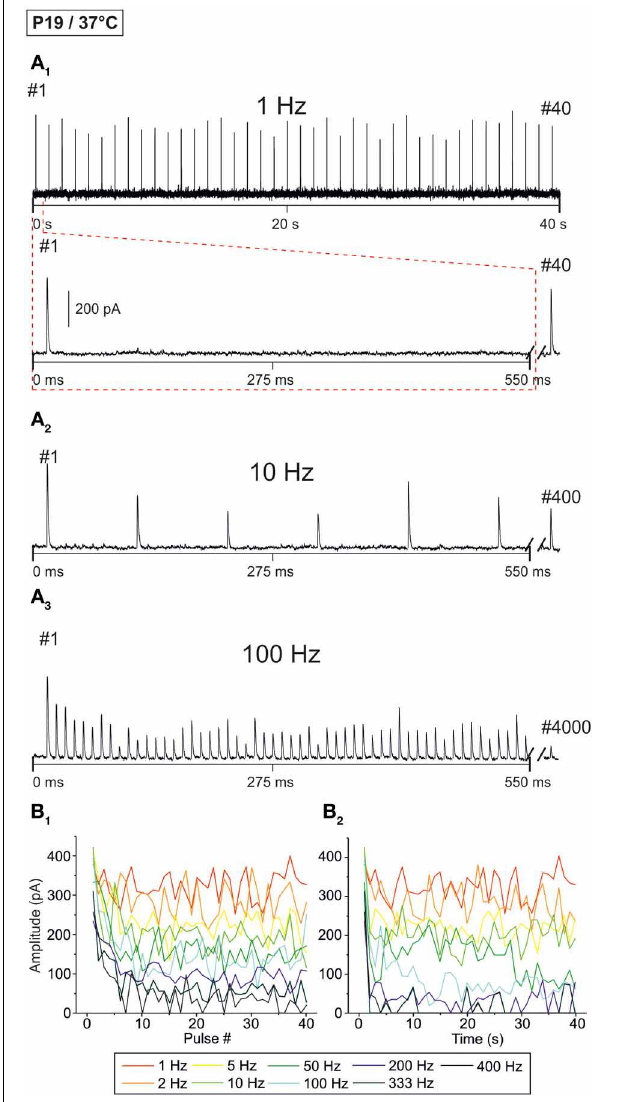
FIGURE 6 | Frequency-dependent changes in evoked glycinergic IPSCs obtained at P19/37 ◦ C. (A 1 ) Original 40s recording of a representative LSO neuron during 1Hz stimulation (top). The first 550ms are time-expanded in thebottomtrace(seered-stippledline).ThelastIPSCduringthe40-s-periodis shown on the right and depicted by its pulse number (#40). The 200pA calibration bar is also valid for panels (A 2 ,A 3 ) . (A 2 ,A 3 ) , IPSCs during 10 and 100Hz stimulation, respectively, from the same neuron as in panel (A 1 ) . Similar to (A 1 ) , the last IPSC during the 40-s-period is shown on the right (#400 and #4000, respectively). (B 1 ) Time course of IPSC peak amplitudes from two LSO neurons at eight stimulation frequencies, ranging from 1–400Hz (for color code, see inset). Peak values to the first 40 pulses (pulse #1–40) are plotted. (B 2 ) Like (B 1 ) , but depicting the time course of IPSC peak amplitudesduringthecomplete40-s-periods.Foreachstimulationfrequency, peak amplitudes were sampled at